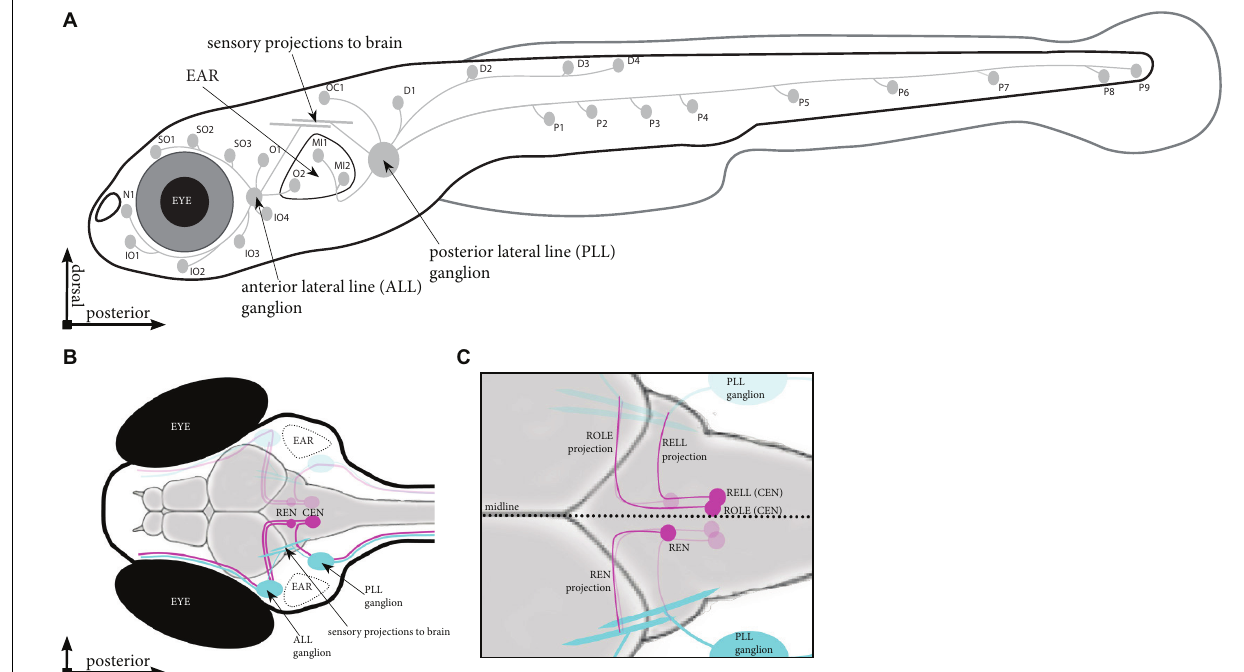
FIGURE 1 | Schematic overview of the lateral line in zebrafish. (A) Location of the neuromasts in a zebrafish larva at 5 days post fertilisation (dpf). Indicated are the neuromasts identified in Tg(HGn39D), the anterior and posterior sensory ganglia and the projections they send to the neuromasts and into the brain. (B) Dorsal view of the head of a 5 dpf zebrafish larva. Indicated are the sensory ganglia and their projections (cyan) as well as the REN and CEN in the rhombencephalon (magenta), where we find the inhibitory efferent cells projecting to the lateral line. (C) Overview of the different cells in the REN and CEN (magenta). The REN contains a single cell type, which sends a projection anteriorly that turns toward the ALL ganglion. The CEN contains two cell types; ROLE, which projects past and follow the projection path of the REN cell; and a RELL cell, which projects till the REN cell, where it turns toward the PLL ganglion. ALL, anterior lateral line; PLL, posterior lateral line; REN, the rostral efferent nucleus; CEN, the caudal efferent nucleus nucleus; ROLE, the rhombencephalic octavolateral efferent neuron; RELL, the rhombencephalic efferent neuron to the lateral